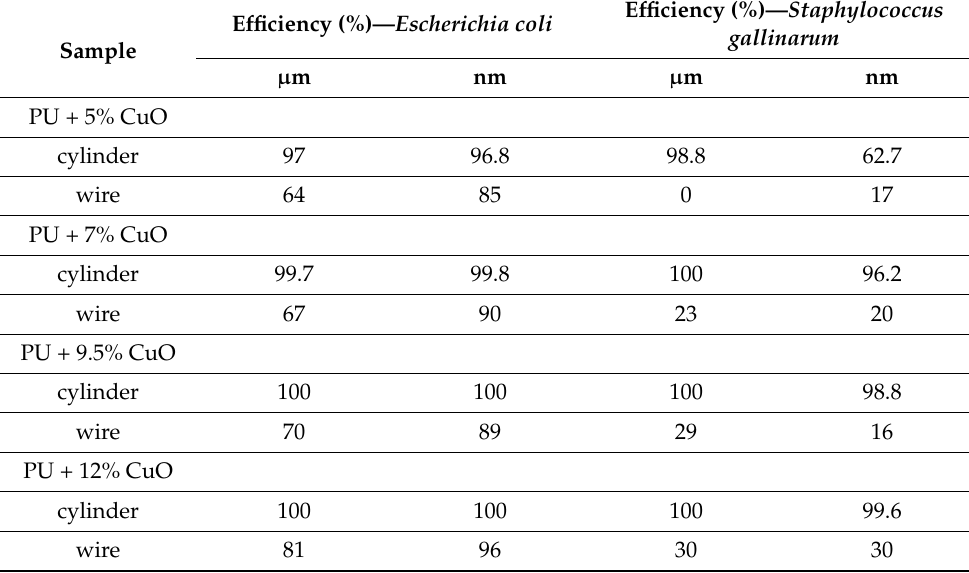
Table 5. Antibacterial efficiency of composite nanofibers (NFs) with micro- and nanoparticles produced from both electrodes against Escherichia coli and Staphylococcus gallinarum (contact time between bacterial solutions and modified samples 24